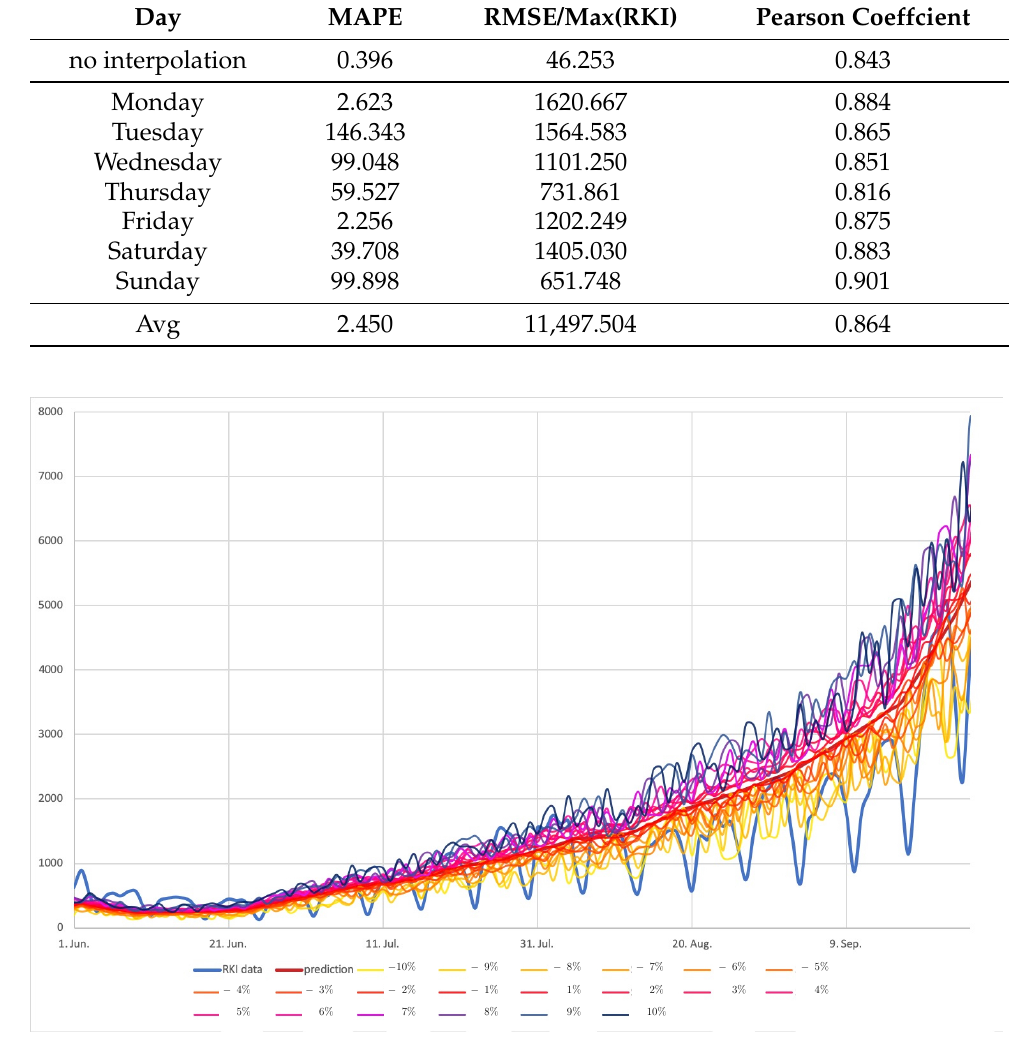
Table 2. Mean absolute percentage error (MAPE), root-mean-square error (RMSE), and Pearson coefficients for the different days, based on the interpolation of the data for their 7-day average.